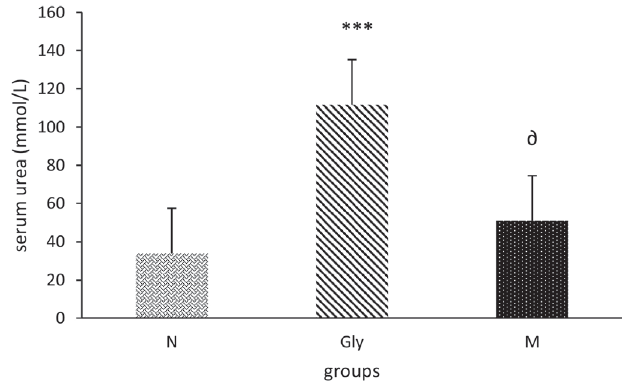
FIGURE 1 - Effects of MSM on serum urea level content in glycerol induced ARF. Each column is represented as the mean±SE. ***p < 0.0001 vs. N, ∂ p < 0.0001 vs. G. N, control group; GLY, Glycerol; M,